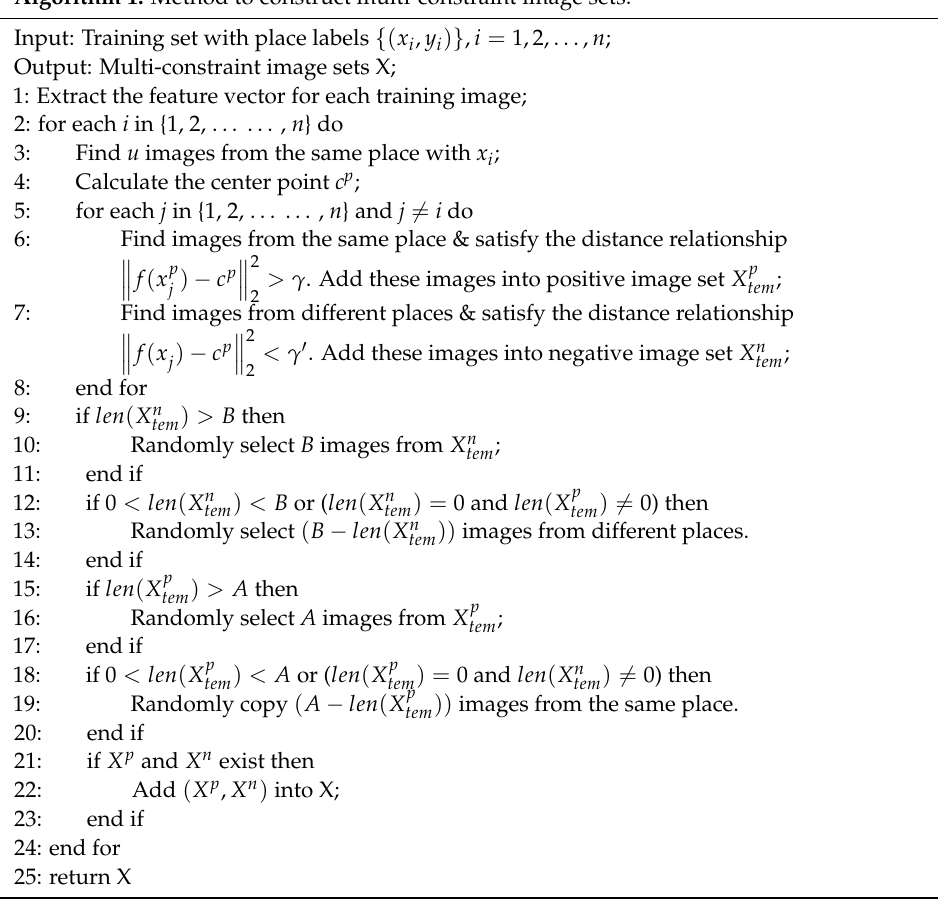
Algorithm 1. Method to construct multi-constraint image